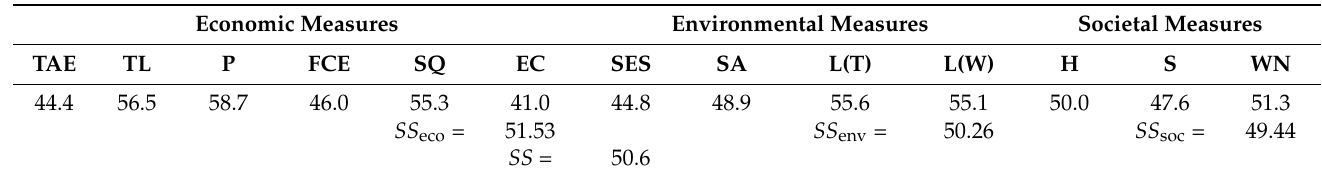
Table 5. The SS results of the example related to the milling process.